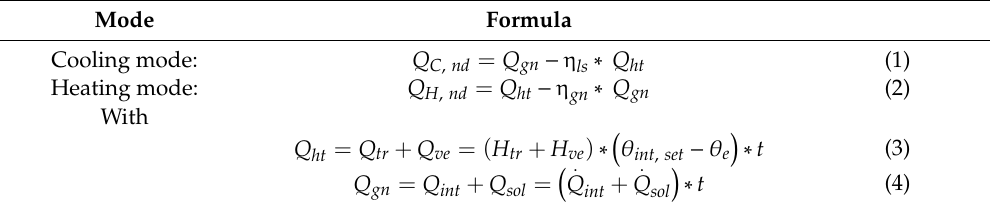
Table 1. Energy needs for heating and cooling